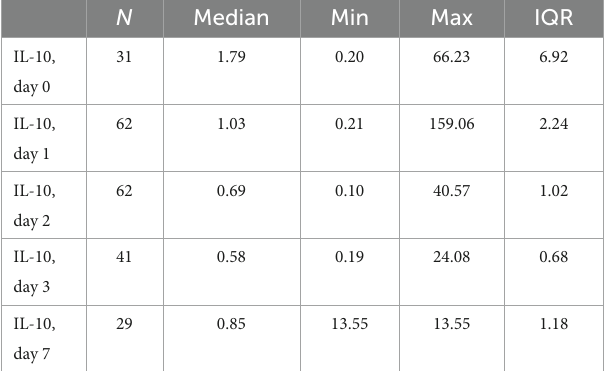
TABLE 2 Levels of IL-10 in days 0–7 within the study cohort (pg/ml).